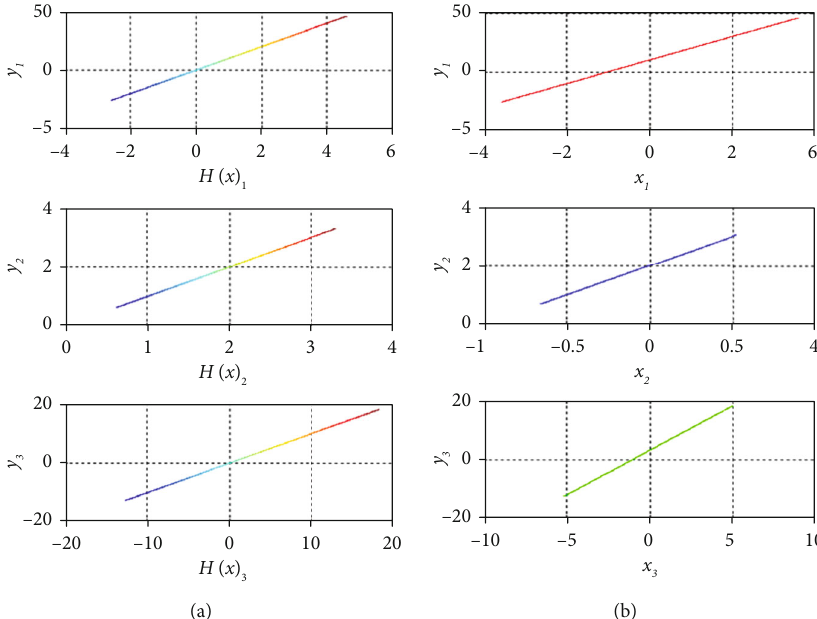
Figure 10: The synchronization relationships of di ff erent state variables in the unidirectionally coupled Chua ’ s circuit. (a) H ð x Þ = ð H ð x Þ Þ T and y = ð y , H ð x Þ , H ð x Þ 1 2 3 synchronization with respect to the linear manifold y = Px + Q